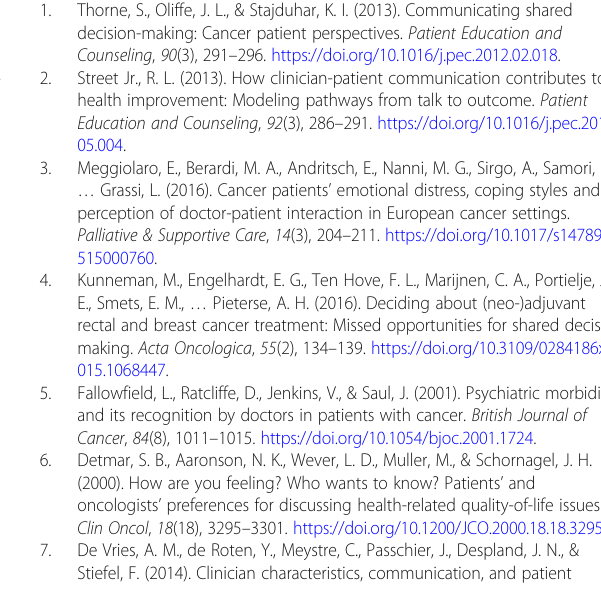
Abbreviations EORTC-QOL-C30: European Organization for Research and Treatment of Cancer Quality of Life C-30; FACIT-Sp: The Functional Assessment of Chronic